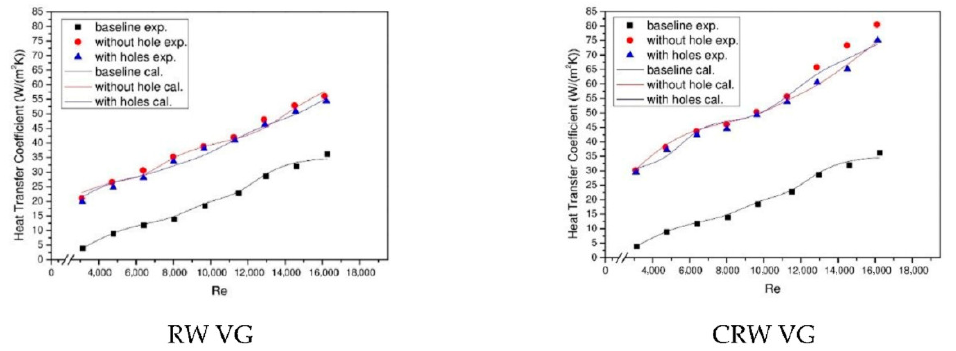
Figure 12. Comparison of convection heat transfer coefficient between with and without holes for installation of VG as well as baseline.